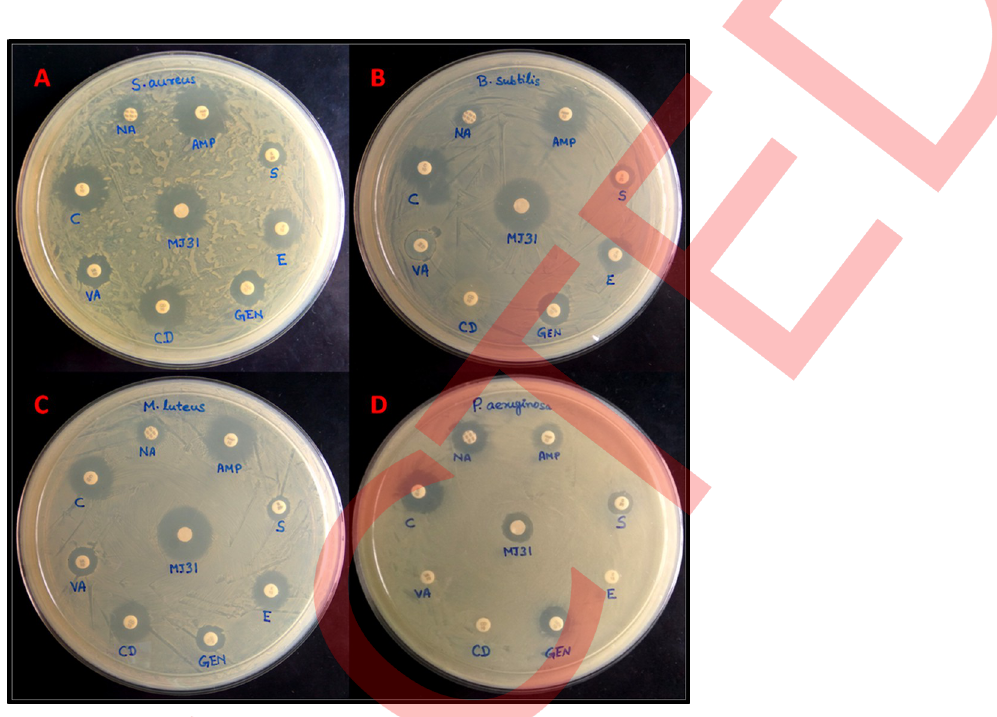
Fig 6. Antimicrobial activity of endophytic fungus A . clavatonanicus strain MJ31, showing zone of inhibition (mm ± SD) along with reference standard antibiotics against A) Staphylococccus aureus ; B) Bacillus subtilis ; C) Micrococcus luteus and D) Pseudomonas aeruginosa .